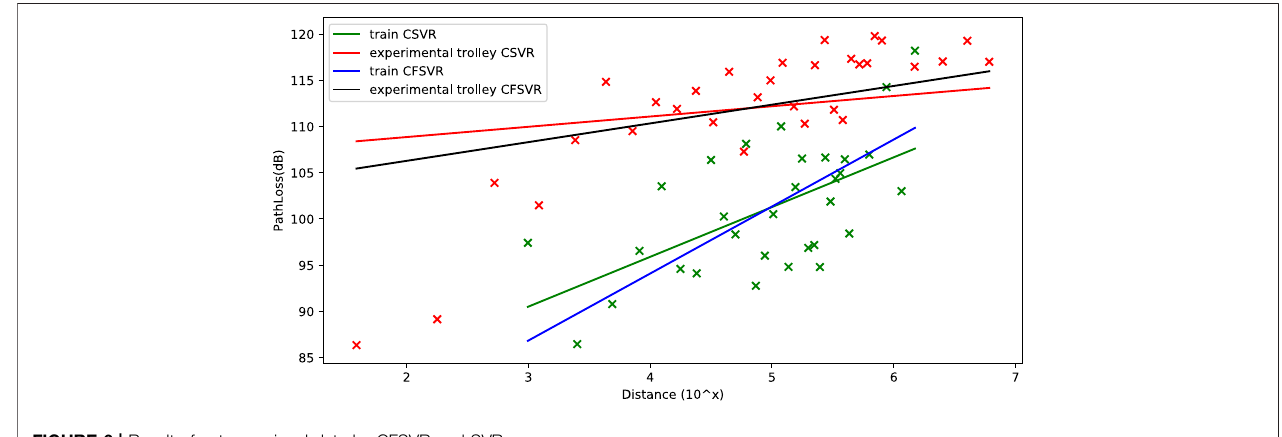
FIGURE 6 | Result of antenna signal data by CFSVR and SVR.